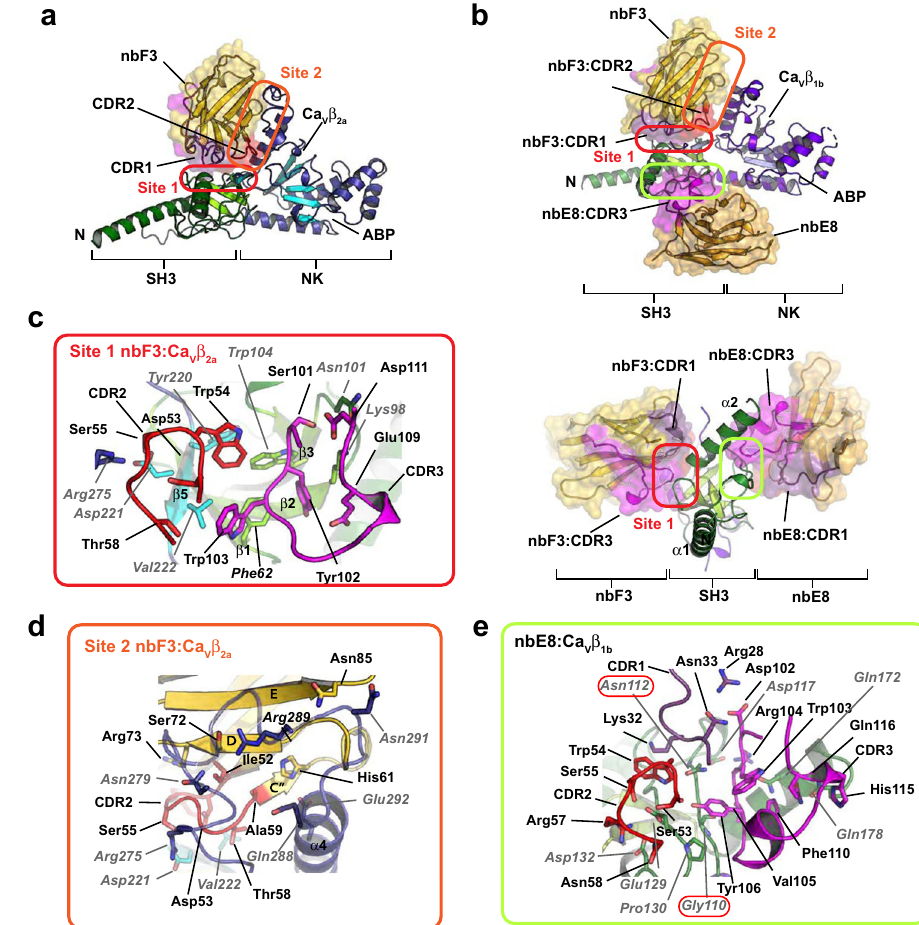
Fig. 3 | Crystal structures of nb.F3 and nb.E8 in complex with Ca V β 1 . a Cartoon diagram of the nb.F3:Ca V β 2a complex. Ca V β 2a SH3 (helices (dark green) and β - strands(lightgreen))andNK(helices(darkblue)and β -strands(cyan))domainsare indicated.Nb.F3(yellow)isshownwithasemi-transparentsurface.Nb.F3Site1and Site 2 binding regions are indicated by the red and orange ovals, respectively. b Cartoon diagram of nb.F3:nb.E8:Ca V β 1b complex. SH3 (helices (green) and β - strands (lime)) and NK (helices (purple) and β -strands (violet)) domains are indi- cated.Nb.F3(yellow)and nb.E8(yelloworange)areshown witha semi-transparent surface.Site 1and Site2binding regionsare indicated bythe red and orange ovals,